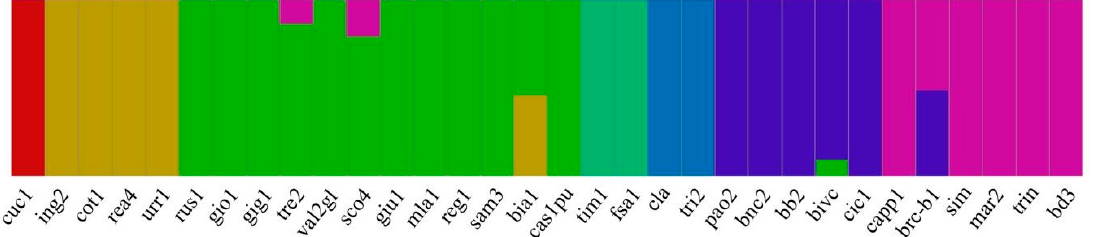
Figure 4. Admixture proportions of the wheat germplasm collection estimated by the FastStructure ( K = 7). Each vertical bar represents a sample. The color proportion for each bar represents the posterior probability of assignment of each individual to one of the seven groups of genetic similarity. The range of assignment probability varied from 0 to 100%.